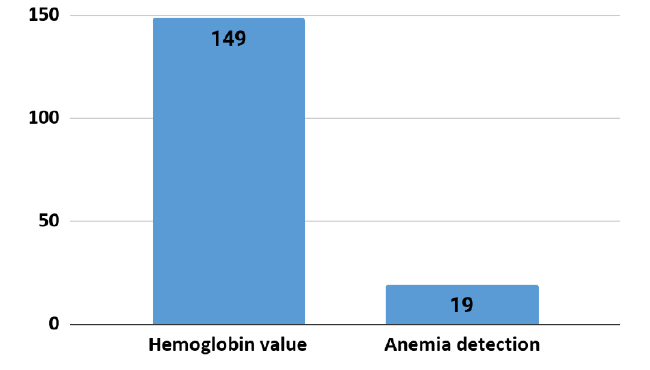
Figure 8. Distribution of assessment goals.